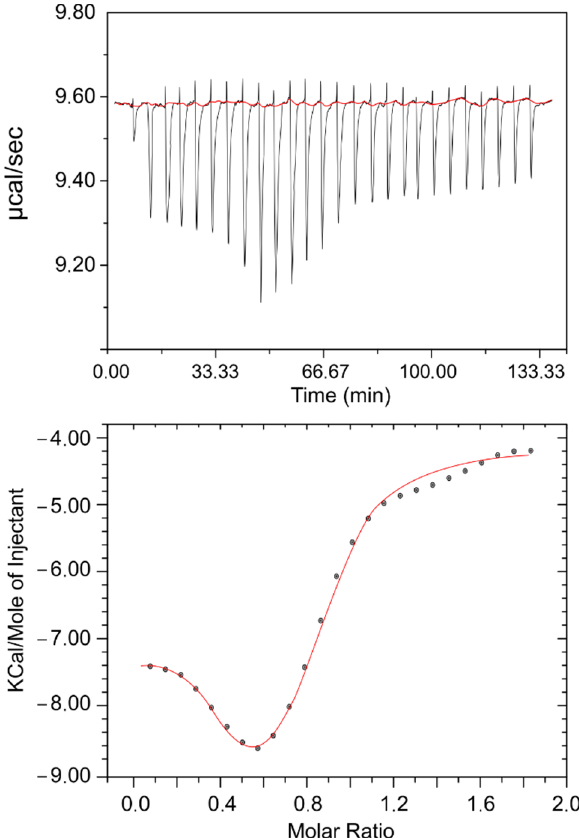
Figure 1. Heat of interaction. ITC results for the titration of the BTS drug (0.5 mM) into the lysozyme solution (0.02 mM) at 298.15 K. Each dot represents an injection. The heat of the first injection was neglected to get a more accurate fitting. Table 1. Contents (in %) of the α -helices and β -sheets elements in lysozyme as a function of BTS concentration